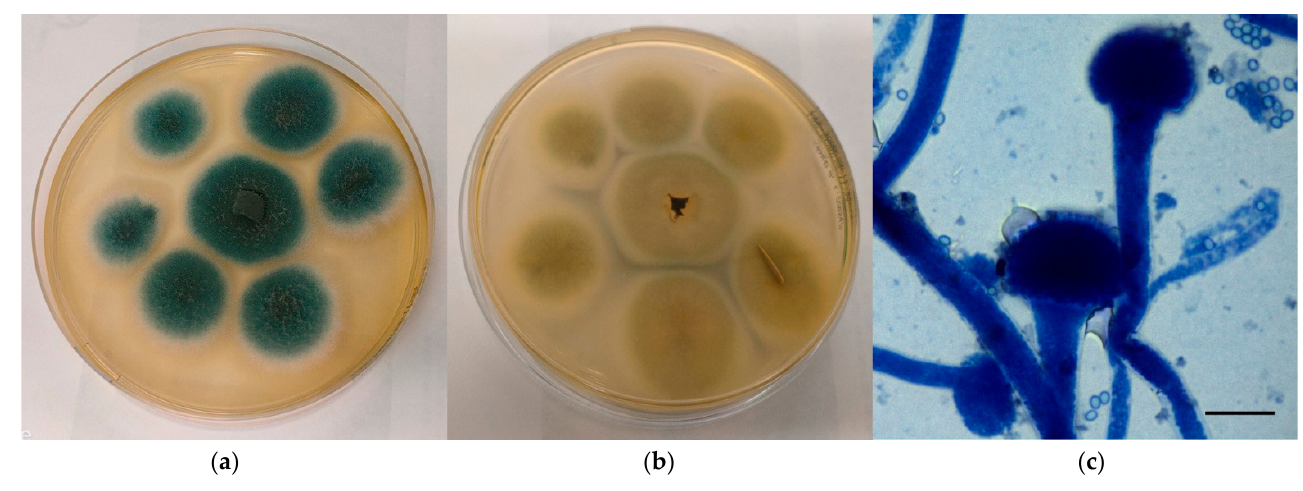
Figure 1. Mycological examination of the colonies referable to A. fumigatus complex grown onto CZA. ( a ) Macroscopic surface of the colonies; ( b ) Macroscopic reverse of the colonies; ( c ) Microscopic features of the colonies (methylene blue staining, ×100, bar 10 µm). A. flavus complex colonies appeared yellow to yellow-green in colour, with a cream-colored reverse; the surface was grainy, often with radial grooves and edged in white (Figure 2a,b). Microscopically, hyphae hyaline and septate, conidiophores with rough wall, vesicles dome or claviform with phialides originating, both directly and from metulae ; on the entire vesicle surface, spherical and echinulated conidia were noticed (Figure 2c). Young sterile colonies referable to black aspergilli appeared white-yellow in colour at maturity, covered by a layer of black conidial heads with a cream-colored reverse; the surface was grainy and edged in white (Figure 3a,b). Microscopically, hyphae hyaline and septate, smooth conidiophores with a tick wall, spherical vesicles with phialides originating from metulae on the entire vesicle surface, spherical/oval rough conidia were observed (Figure